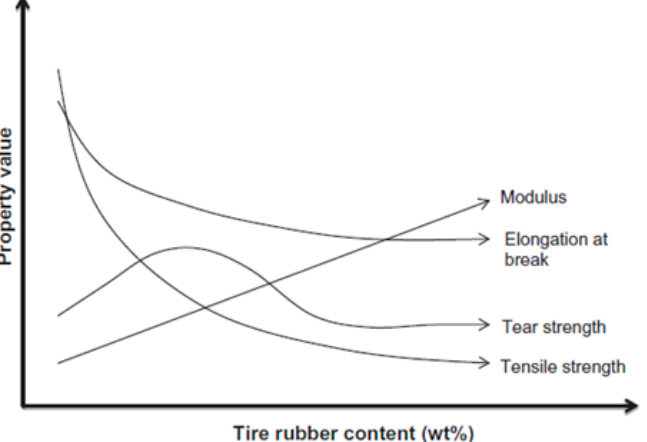
Figure 31. The effect of tire rubber content on the mechanical properties of rubber blends (reproduced with permission from [16]).